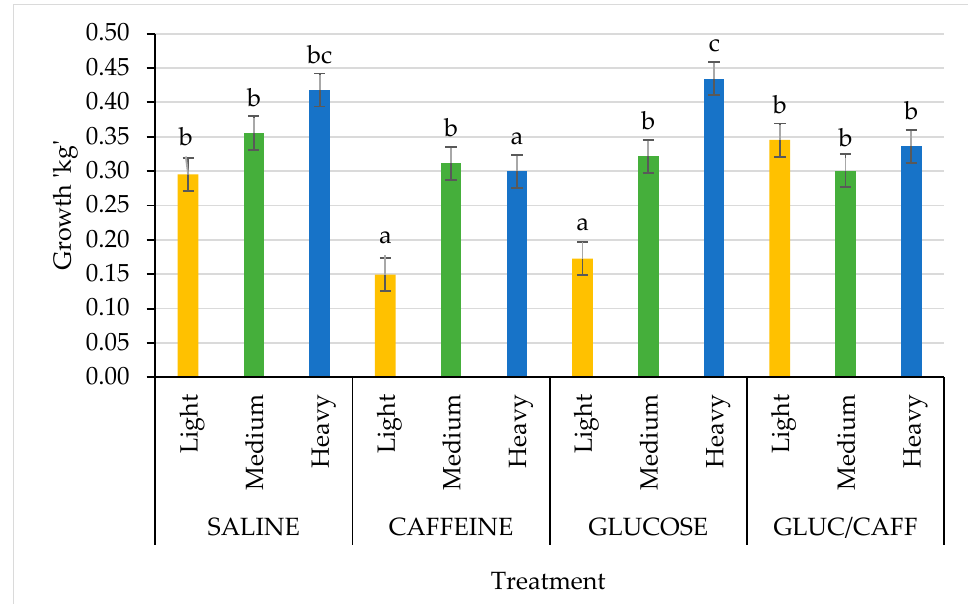
Figure 1. Comparison of growth for birth weight categories (light (yellow): < 0.9 kg, medium (green): 1–1.4 kg, heavy (blue): > 1.5 kg) from day one to day three of age between the four treatments: saline (SAL), caffeine (CAFF), glucose (GLUC), and caffeine plus glucose (CAFF-GLUC). Means with differing letters (abc) are significantly different ( p < 0.05). Data shown as mean ± SEM (error bars).